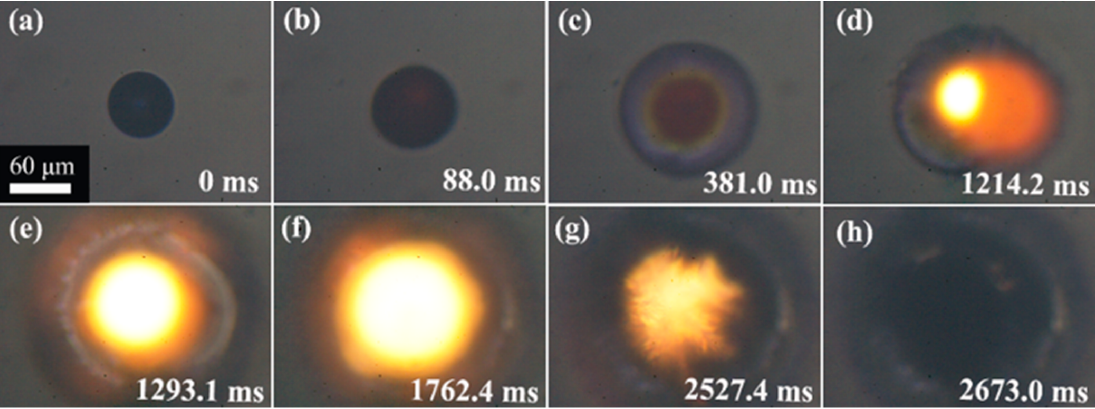
Figure 19. ( a – h ) Representative snapshots of a single Al-Li alloy microparticle burned in N 2. The characteristic parameters of single Al-Li alloy microparticles burned in air and in N 2 were compared in 10 runs of repetitive experiments under a laser power of 2000 mW. The results are listed in Table 2. The ignition delay time of Al-Li alloy microparticles in N 2 increased, the gas-phase combustion time reduced, and the total combustion time increased. of 68.4%. Since the content of Li in Al-Li alloy is less (~1%) and Al does not easily